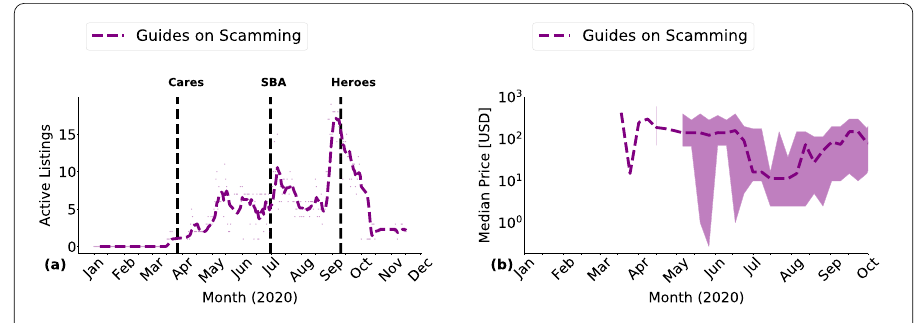
Figure 9 Wikipedia page visits for pages relative to ( a ) PPE , ( b ) hydroxychloroquine, chloroquine and azitrhomycin. Number of tweets mentioning ( c ) PPE , ( d ) hydroxychloroquine, chloroquine and azitrhomycin. Panels ( a ) and ( b ) corresponds to Fig. 5( a ) in the main text, while panels ( c ) and ( d ) to Fig. 5( b ). The main difference between these panels and Fig. 5( a ) and ( b ) is the linear scale on y axis